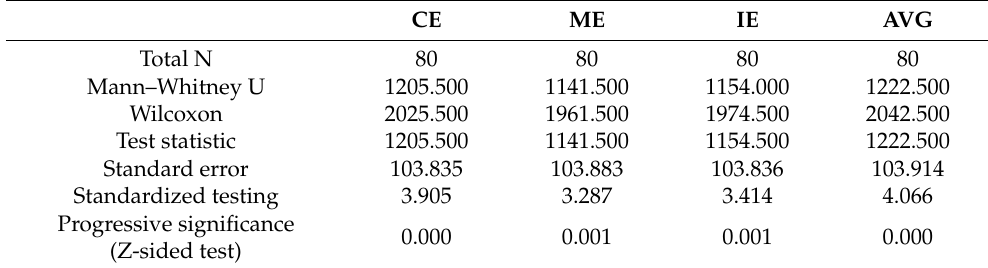
Figure 4. Gaussian mixture model used to cluster the eggs with similar hatching rates (HRs) according to the number of erosion-crater pores and the eggshell thicknesses ( a , b ) in the CE, ME, and IE regions. Table 2. Mann–Whitney-U-test results for the number of erosion-crater pores on the surfaces.